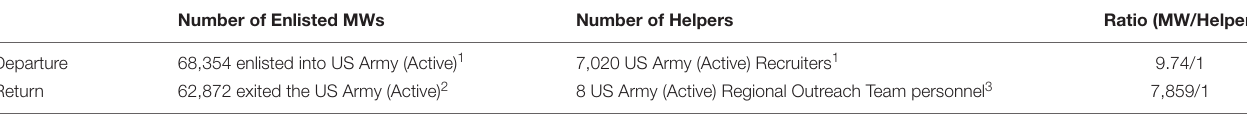
TABLE 2 | Ratio of US army ‘helpers’ in modern warriors’ hometowns (departure vs.